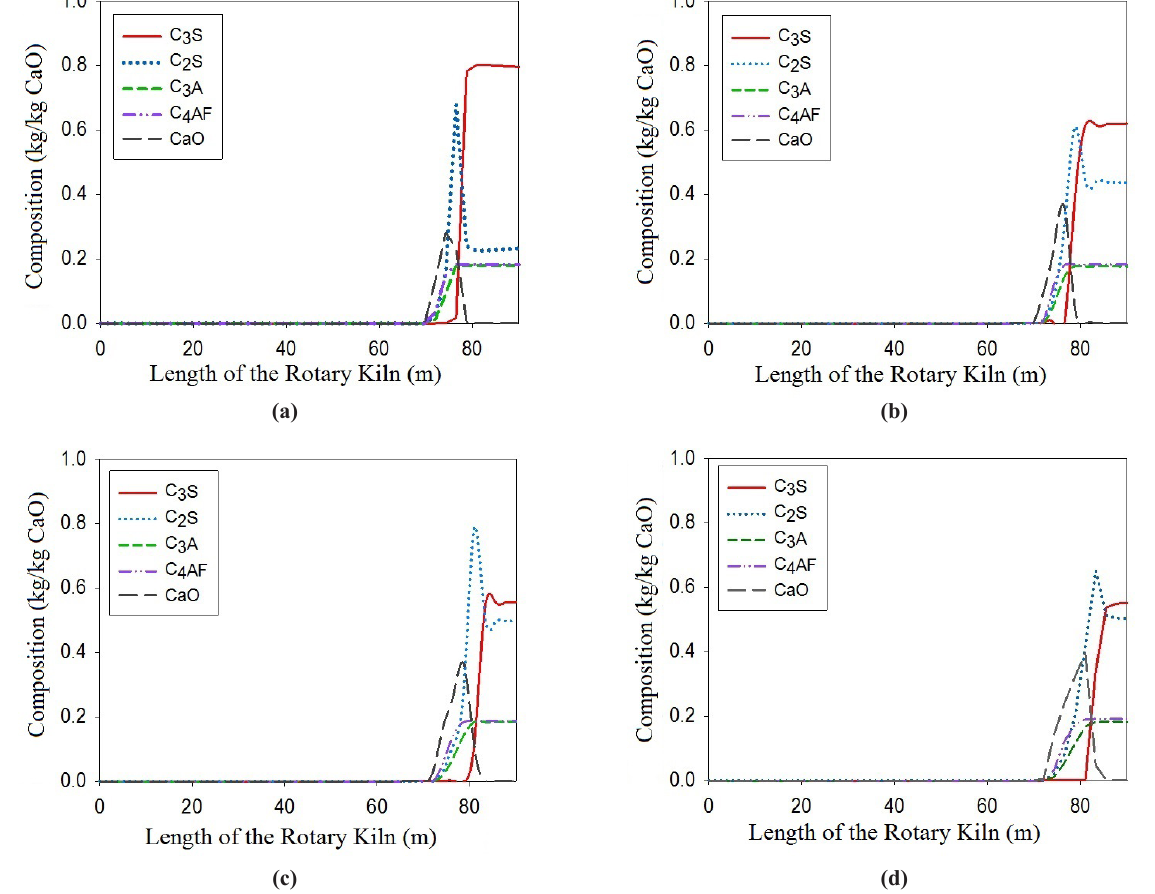
S, C S, C A, C AF and CaO in the industrial rotary kiln at steady state. ( a ) -20% of inlet gas 3 2 3 4